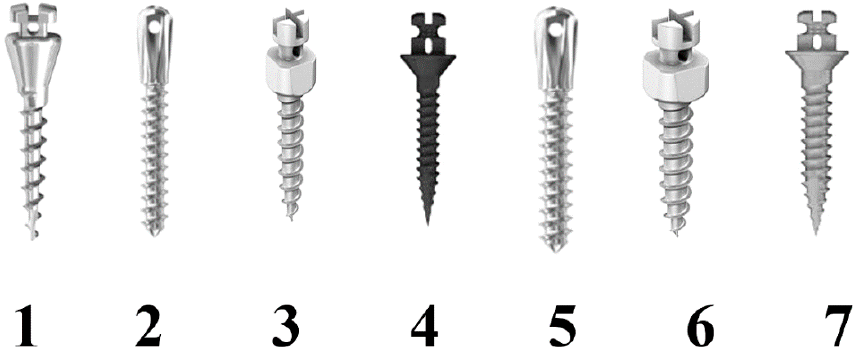
Figure 1. Miniscrews with different diameters tested in the present investigation. 1: 1.5 mm HDC—2: 1.5 mm Leone—3: 1.5 mm Orteam—4: 1.5 mm Kristal—5: 2.0 mm Leone—6: 2.0 mm 1.5 mm Leone—3: 1.5 mm Orteam—4: 1.5 mm Kristal—5: 2.0 mm Leone—6: 2.0 mm Orteam—7: 2.0 mm Kristal.